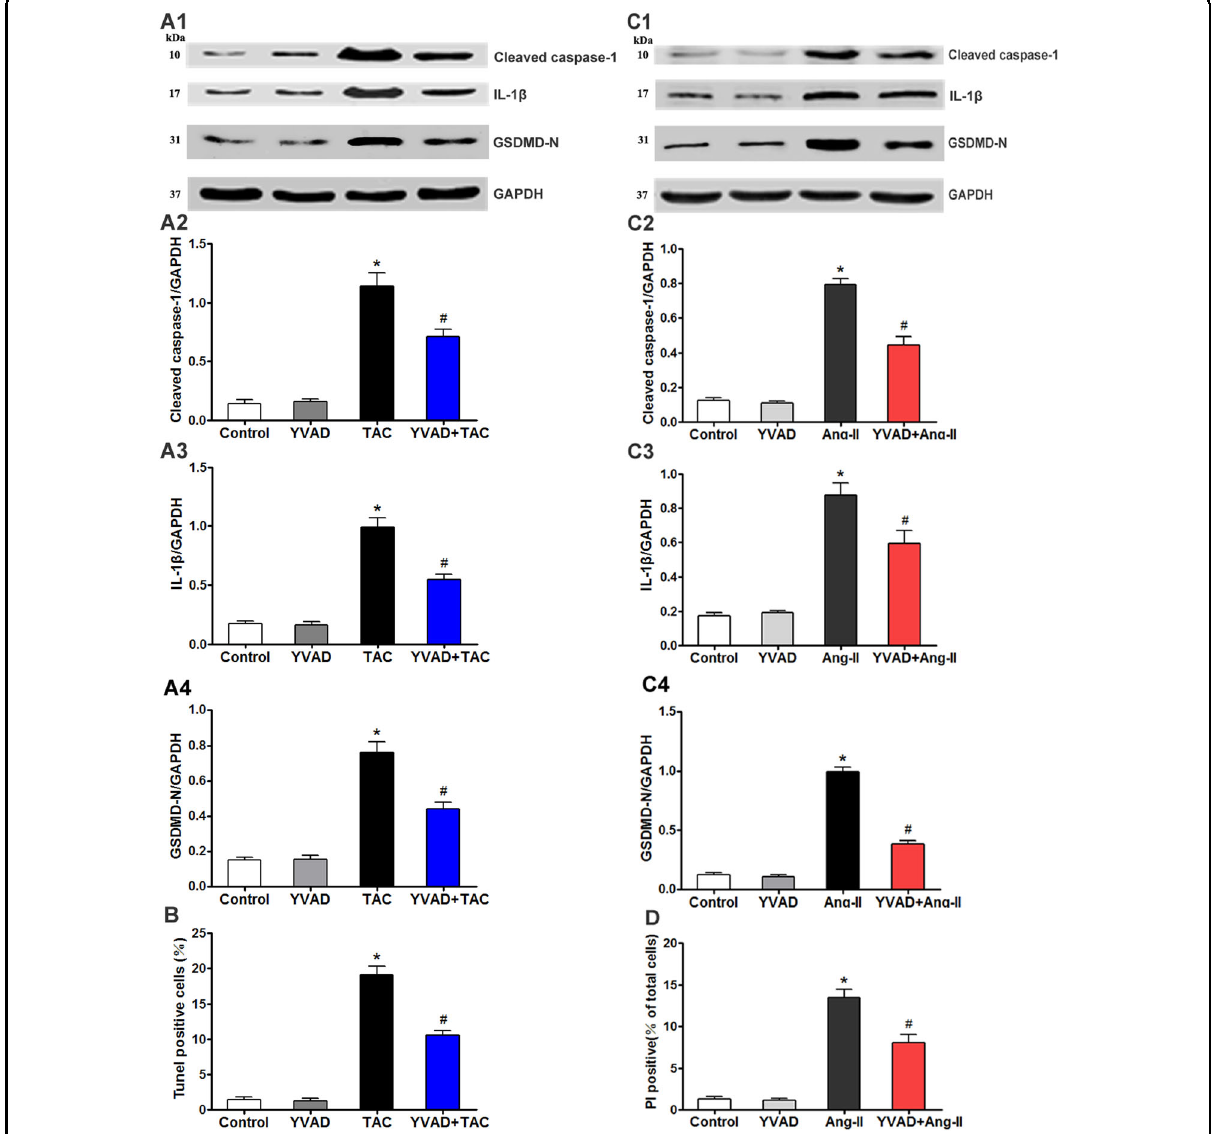
Fig. 2 Caspase-1 inhibition downregulates overload-induced pyroptosis. A Immunoblots showing levels of cleaved caspase-1 ( A1 , A2 ), IL-1 β ( A1 , A3 ), and GSDMD-N ( A1 , A4 ) in the indicated groups. B Percentage of TUNEL-positive cells in the indicated groups. C Immunoblots showing levels of cleaved caspase-1 ( C1 , C2 ), IL-1 β ( C1 , C3 ), and GSDMD-N ( C1 , C4 ) in the suitably treated cardiomyocytes. D Percentage of PI-positive cells in the indicated groups. Results are mean ± SEM, n = 6. * P < 0.01 compared to control, # P < 0.01 compared to TAC group or Ang-II group. YVAD (AC- YVAD-CMK, caspase-1